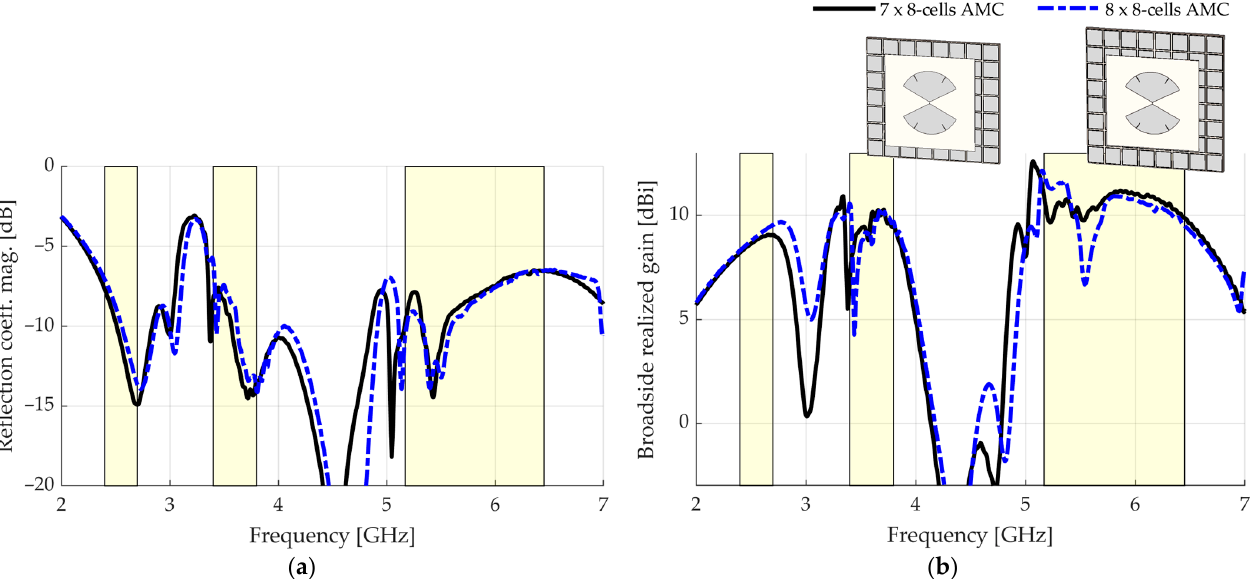
Figure 10. Simulated results for a 7 × 8-cell AMC: ( a ) reflection coefficient magnitude; ( b ) broadside realized gain.